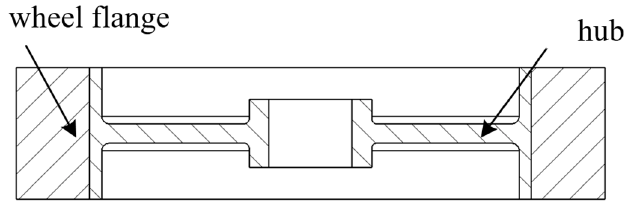
Figure 4. Flywheel rotor structure.